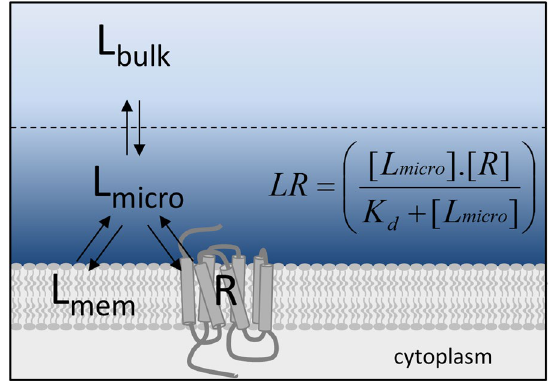
Figure 4. Schematic representation of increased local ligand concentrations in the immediate vicinity of the cell membrane and target receptors compared to the bulk aqueous phase. A ligand concentration gradient may potentially be caused by ligand interactions with both cell membrane components and target receptors (R). To account for heterogeneous ligand distribution in the determination of pharmacological parameters, higher local ligand concentrations (L micro ) may be used, as shown here for affinity (K d )